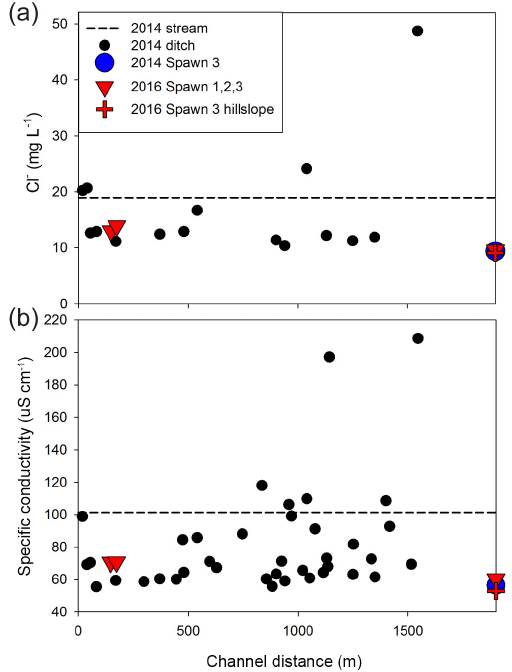
Figure 7. Drainage ditch chemistry throughout the lower Quashnet, showing (a) Cl − and (b) specific conductance that was collected in June 2014, just above the confluence with the main channel. Data are plotted as the distance from the upper flood control structure in the narrow valley reach and are compared to groundwater-seepage data collected in preferential spawning locations and a hillslope